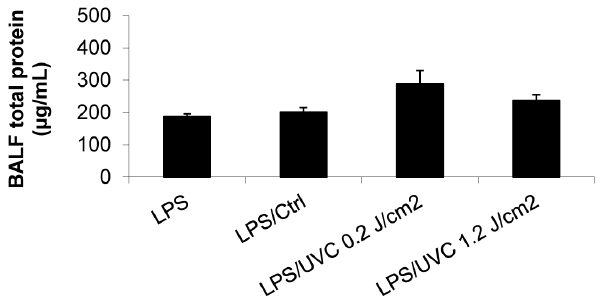
Figure 5. UVC-irradiated HPs did not induce lung injury in the 2-event SCID mouse model. Mice were treated as described above for the 2-event SCID mouse model. Bronchoalveolar fluid (BALF) was collected 1 hour after platelet infusion and the total protein concentration in BALF was measured using BCA protein assay. Mean ± SE, n=5-10.